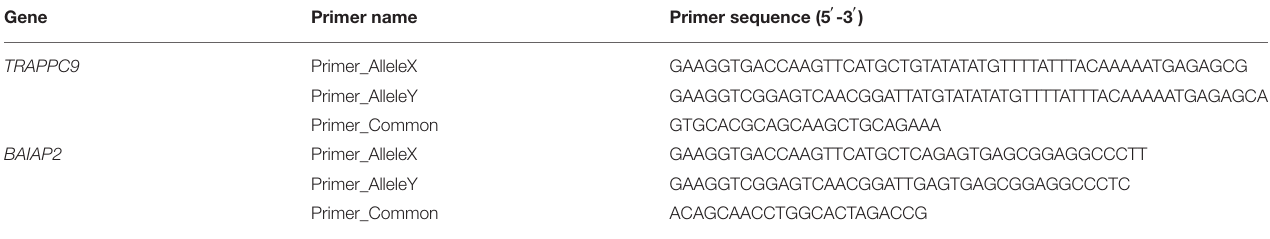
TABLE 2 | KASPar genotyping